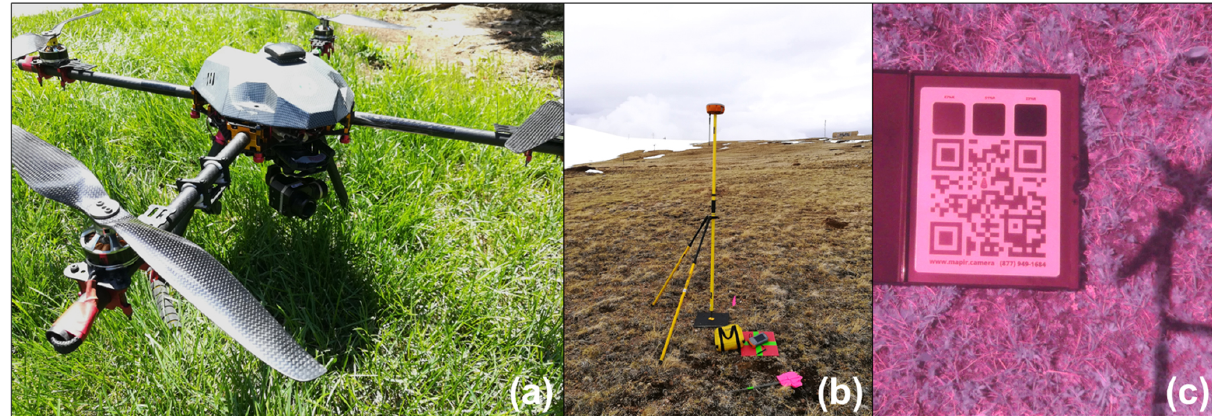
Figure 2. Quadcopter UAS fitted with a thermal camera (a) , installation and survey of GCPs (b) , and a RNIR image of the surface reflectance calibration plate (c) .